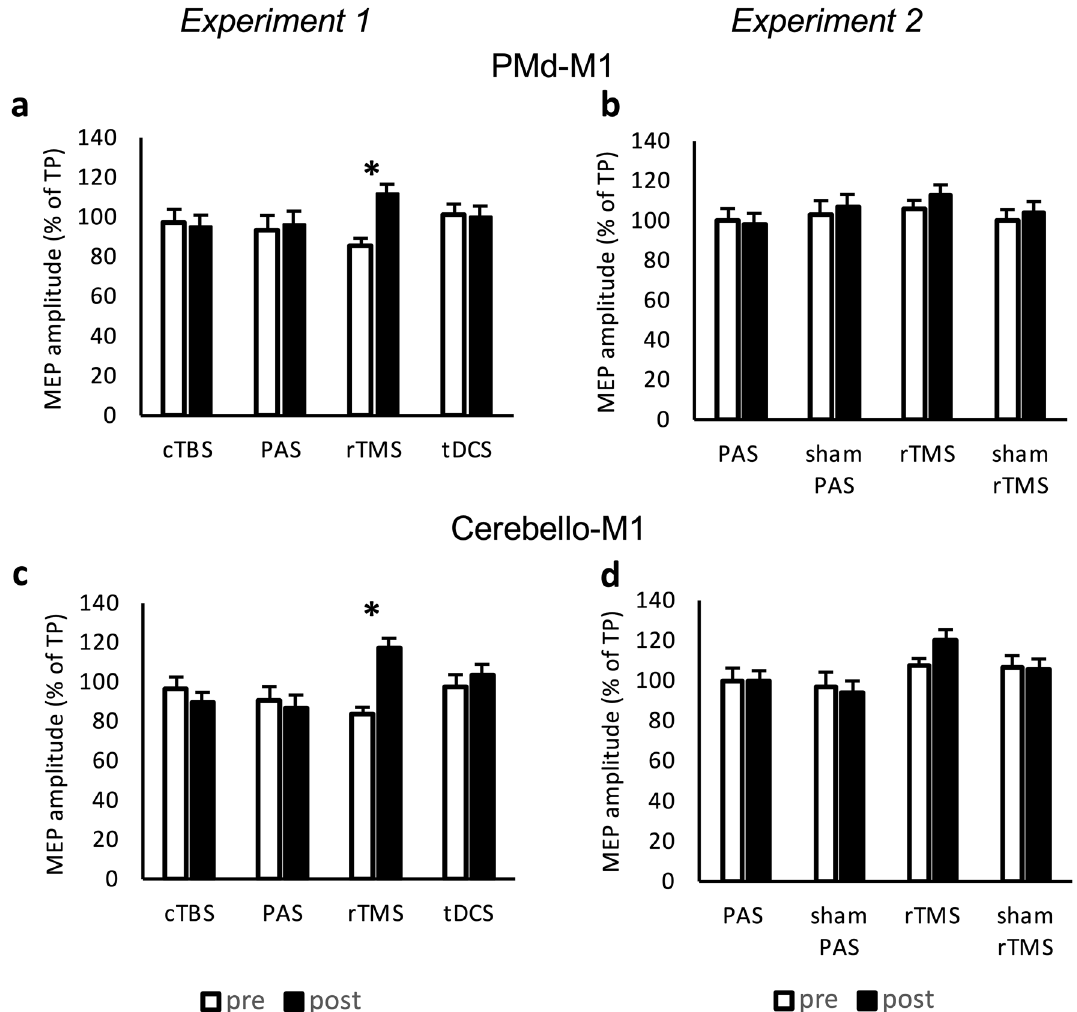
Figure 4. Analysis of dual-pulse TMS (experiments 1 and 2). MEP amplitudes were measured peak-to-peak and indicated in percentage to the MEP generated while only stimulating the primary motor cortex (M1) with a test pulse (TP). Conditioning pulses over PMd were administered before the TP over M1 within a dual-pulse PMd-M1 paradigm ( a and b ). Conditioning pulses were given over the cerebellum prior to TP M1 stimulation within the dual-pulse cerebello-M1 paradigm (c and d). Error bars indicate standard error of mean. Graphs are marked with * when comparison of values with student t-test resulted in p value < 0.05 (Bonferroni–Holm- corrected). ( a ) Significant increase of PMd-M1 interaction only after rTMS intervention ( p = 0.004). ( b ) Increase of PMd-M1 interaction after rTMS intervention without significance ( p = 0.250). ( c ) Significant increase of cerebello-M1 interaction after rTMS intervention ( p < 0.001) ( d ) Increase of cerebello-M1 interaction after rTMS intervention with a trend to significance ( p = 0.057). MEP motor evoked potential, TP test pulse over primary motor cortex, PMd dorsal premotor cortex, M1 primary motor cortex, PAS paired associative stimulation, rTMS repetitive transcranial magnetic stimulation, cTBS continuous theta-burst, tDCS transcranial direct current stimulation, ISI interstimulus Effects on conditioned MEP amplitudes. Effects on PMd-M1 and cerebello-M1 interactions. ANOVA on con- ditioned MEP amplitudes for PMd-M1 interaction showed a main effect for TIME (F(1,37) = 8.25, p = 0.007, η 2 p = 0.182) and an interaction between INTERVENTION and TIME (F(1,37) = 5.47, p = 0.025, hoc analysis showed facilitation of PMd-M1 interaction after rTMS (t = −3.70, p = 0.002) (Fig. 6b). Analysis of cerebello-M1 interaction revealed a main effect of TIME (F(1,37) = 5.95, p = 0.020, η 2 p = 0.154) and INTERVENTION (F(1,37) = 6.73, p = 0.014, η 2 p = 0.139) and an interaction between INTERVENTION and TIME (F(1,37) = 13.17, p < 0.001, η 2 p = 0.263). Post hoc test showed a significant facilitation after rTMS (t = −4.32, p < 0.001) (Fig. 6c). Effects on cerebello-PMd-M1 interaction. Analysis of conditioned MEP for cerebello-PMd-M1 triple-pulse did not show any main effects or interactions of factors (Fig. 6d).